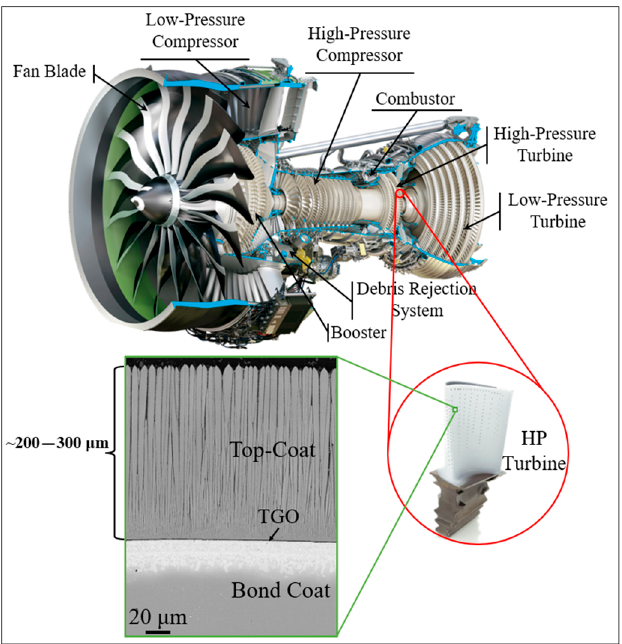
Figure 4. Cutaway view of aero-engine GE-9X, thermal barrier coating (TBC) on high-pressure blade, and scanning electron microscope (SEM) image of a cross-section TBC by EB-PVD 7 wt % yttria-stabilized zirconia (7YSZ). (Engine and blade images from GE aviation, and SEM micrographs adapted from Ref. [44] ).